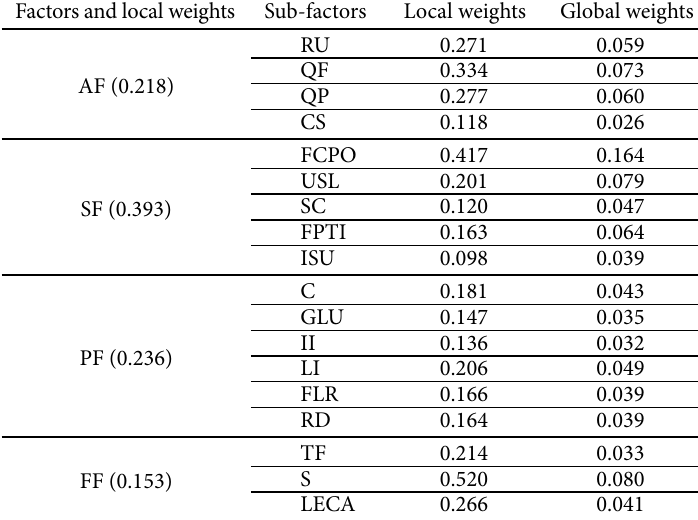
Table 10. Computed global weights for sub-factors Factors and local